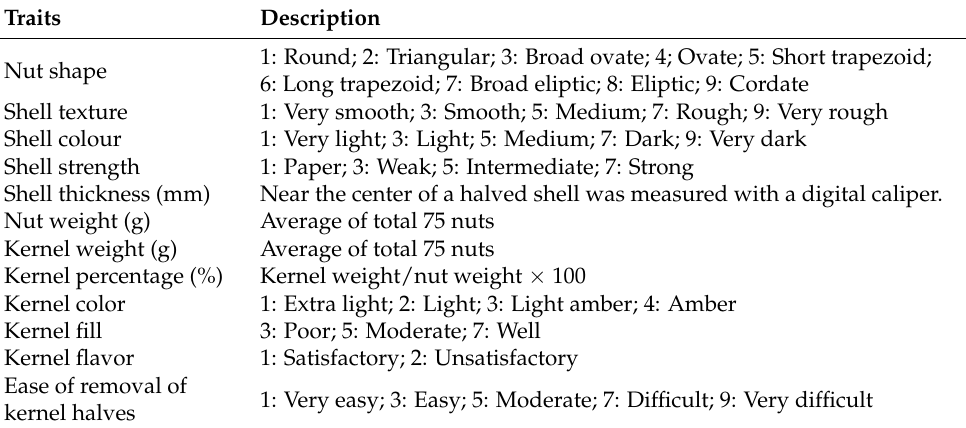
Table 2. Description of the pomological